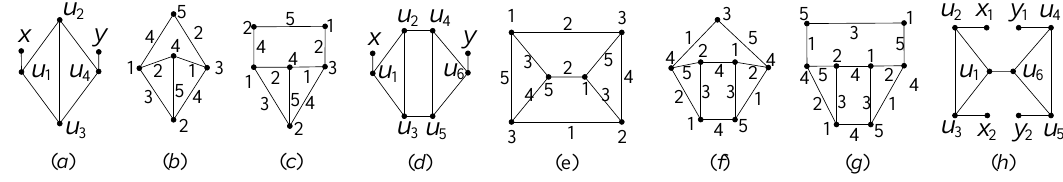
Figure 2. unavoidable